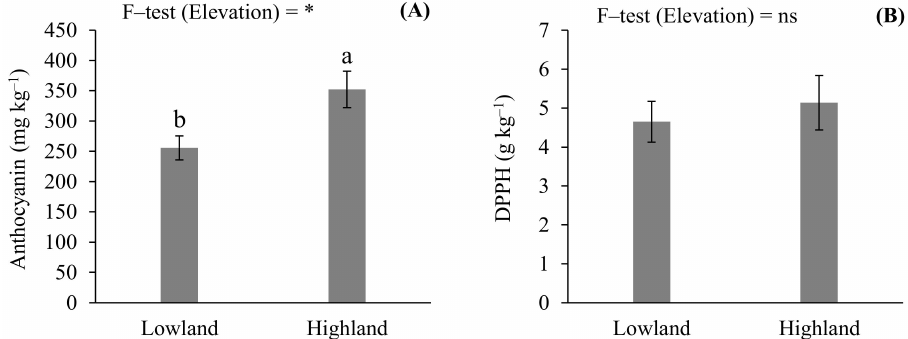
Figure 1. Anthocyanin concentration of the high-anthocyanin PES variety ( A ) and the DPPH activity of the high-antioxidant capacity KAK variety ( B ) grown at lowland and highland elevations. Data were analyzed by F-tests (* p < 0.05, ns: non − significant p < 0.05). Different letters indicate least significant differences ( p < 0.05). The values of anthocyanin concentration and DPPH activity are expressed as mean ± SD ( n = 4).